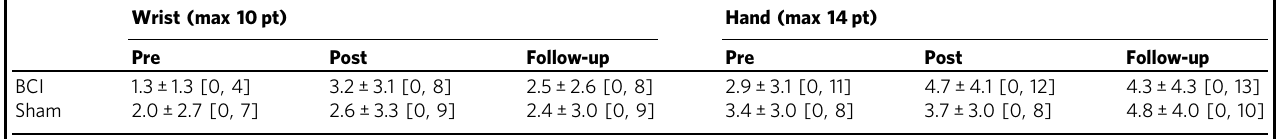
Table 2 FMA-UE subscores for the Wrist and Hand sections Wrist (max 10